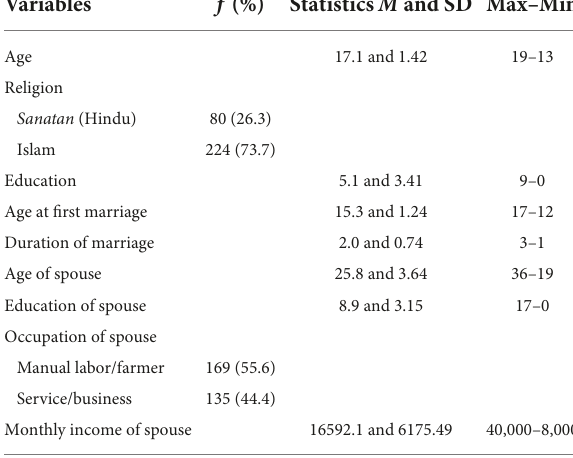
TABLE 1 Socio-demographic information of the